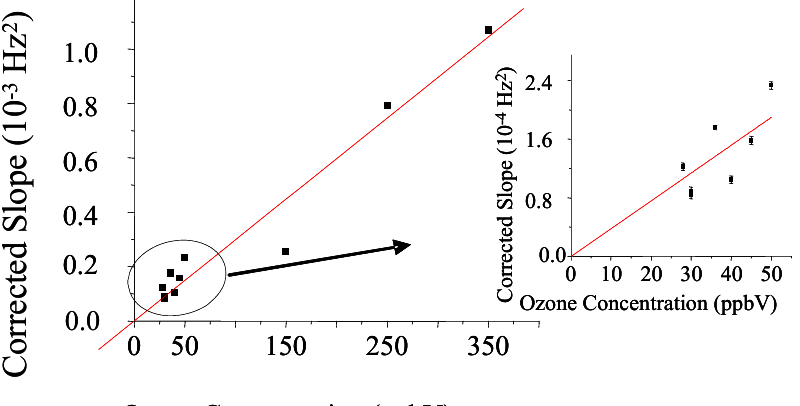
Figure 3. Calibration plots of the response of different tuning fork sensors vs ozone concentration. The inserted figure is the tuning fork response obtained at low ozone concentration range. The response of the sensors (corrected slope) is the frequency slope obtained at a given ozone concentration corrected by subtraction of the frequency slope obtained in presence of ozone-free exposure. The corrected frequency slope is proportional to ozone concentration. A least square linear fitting of the response gives a correlation factor of 3.0 × 10 -6 ± 1.7 × 10 -7 Hz 2 /ppbV with 5.6% error, indicating the sensitivity of the response is well-maintained across different ozone QTF sensors, and concentration